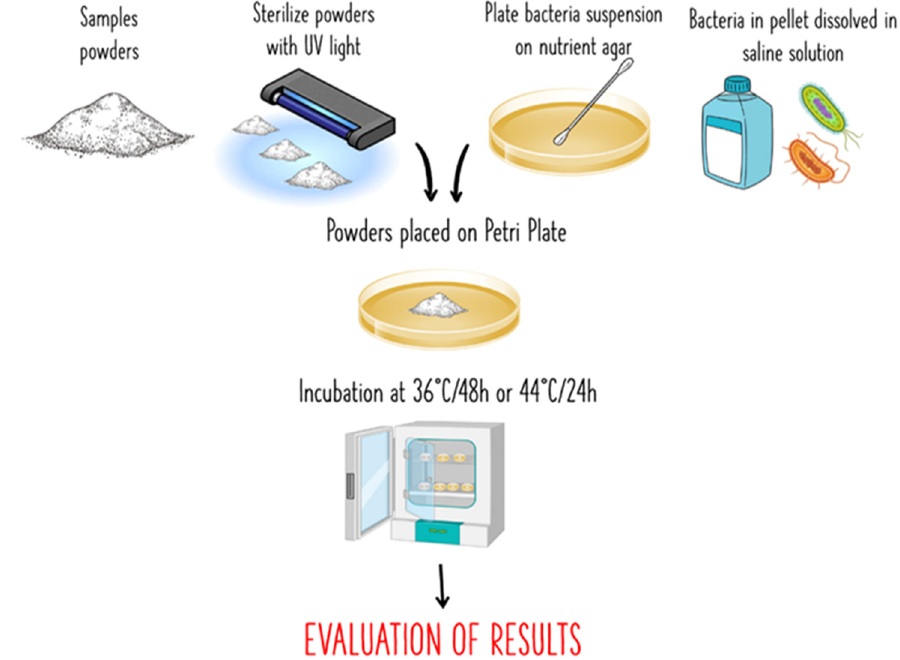
Figure 2: Flowchart procedure for the evaluation of the antibacterial